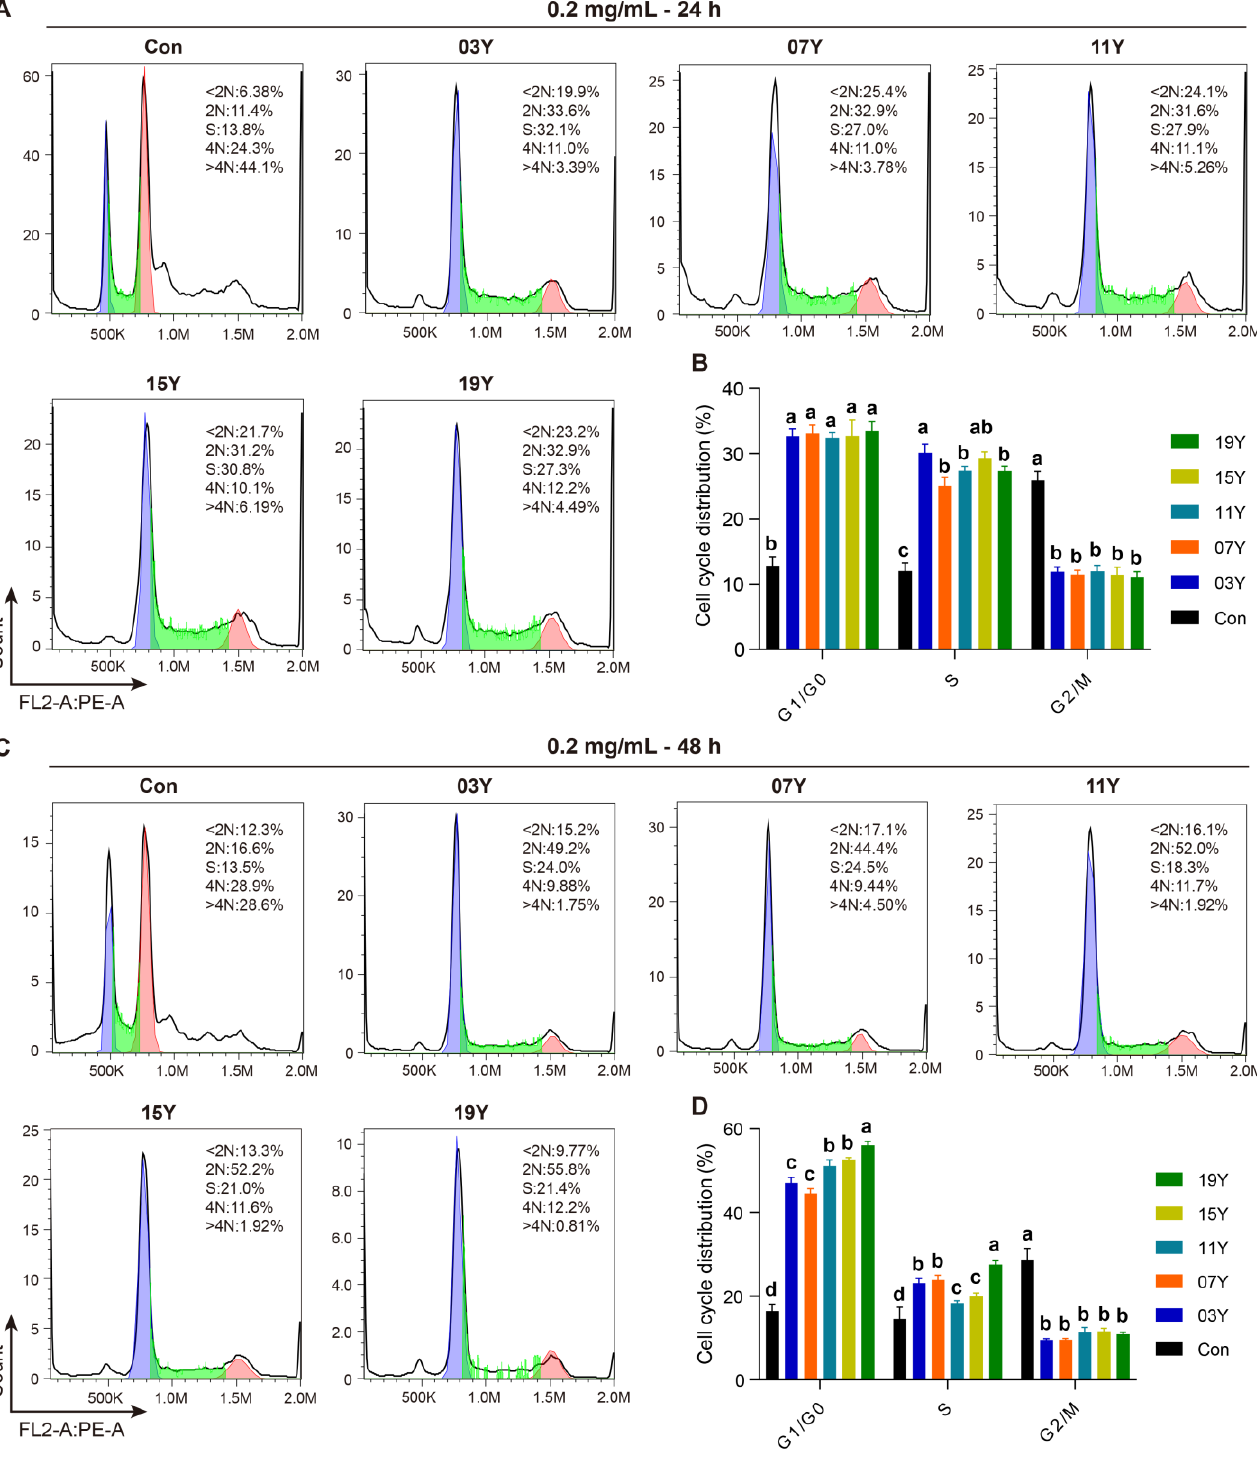
Figure 3. The tea extract inhibited HT-29 cell-cycle progression. HT-29 cells were treated with 0.2 mg/mL extracts of different tea samples 03Y , 07Y , 11Y , 15Y and 19Y for 24 and 48 h, respectively ( A , C ). The phase ratios of total cell cycle in each group were examined using flow cytometry ( B , D ). One-way ANOVA analysis was performed between the treatments of multiple tea samples. The different lowercase letters (a, b, c, d) in the same group show the significant differences at p < 0.05 level.